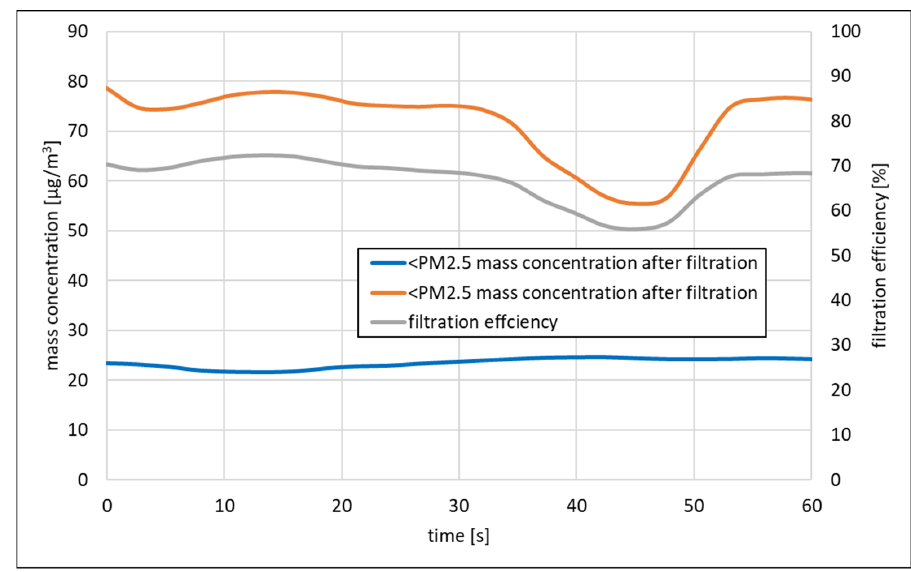
Figure 7. The change in mass concentrations of dust after application of the H13 HEPA filter element regarding filtration efficiency (temperature: 15 °C, relative humidity: 45%).